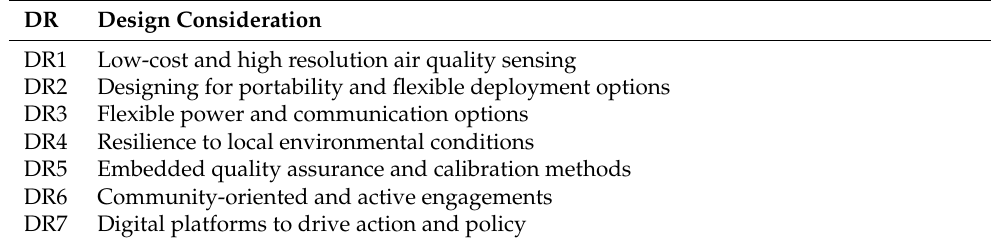
Table 1. Design considerations for an urban air quality sensing system in a low-resource